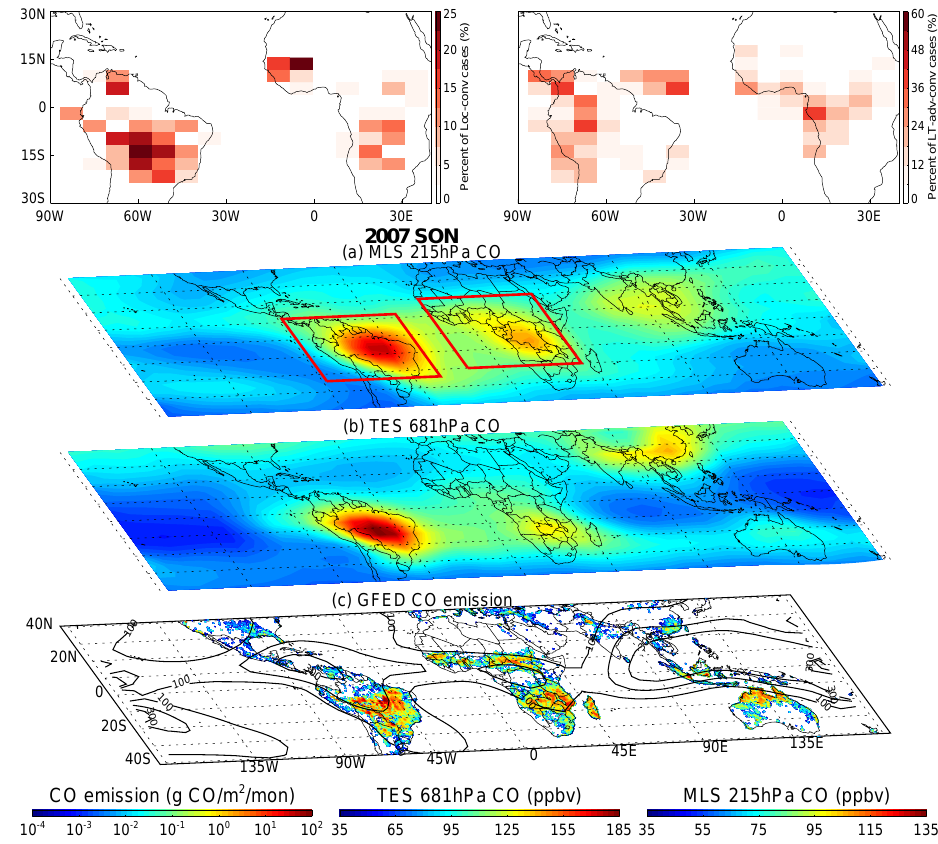
Fig. 7. As in Fig. 4, but for September–November